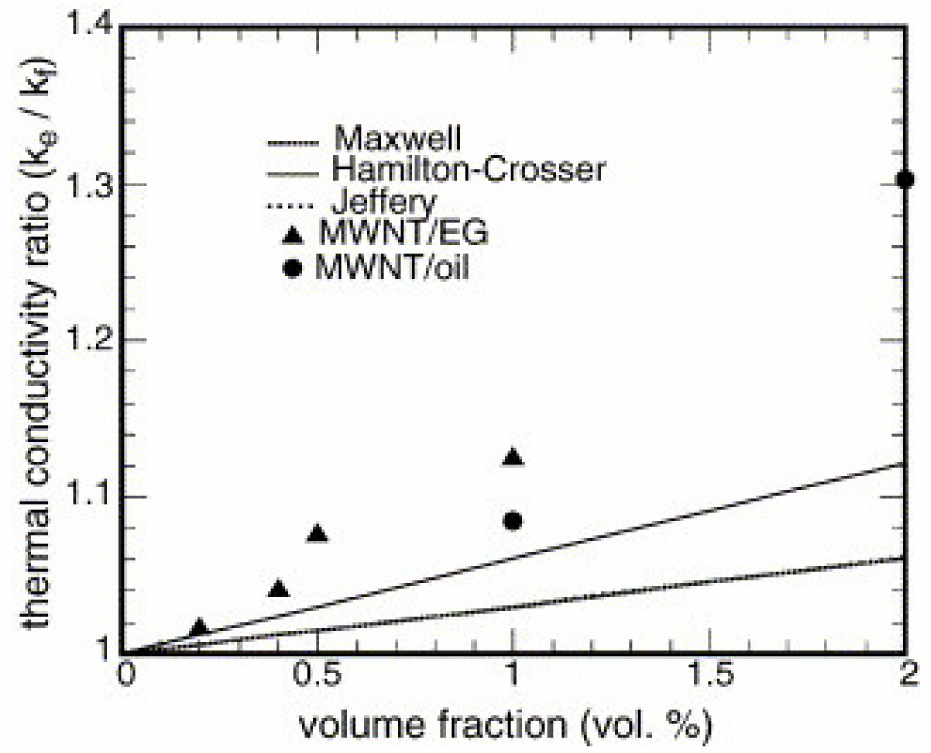
Figure 12. The influence of nanoparticle concentrations on thermal